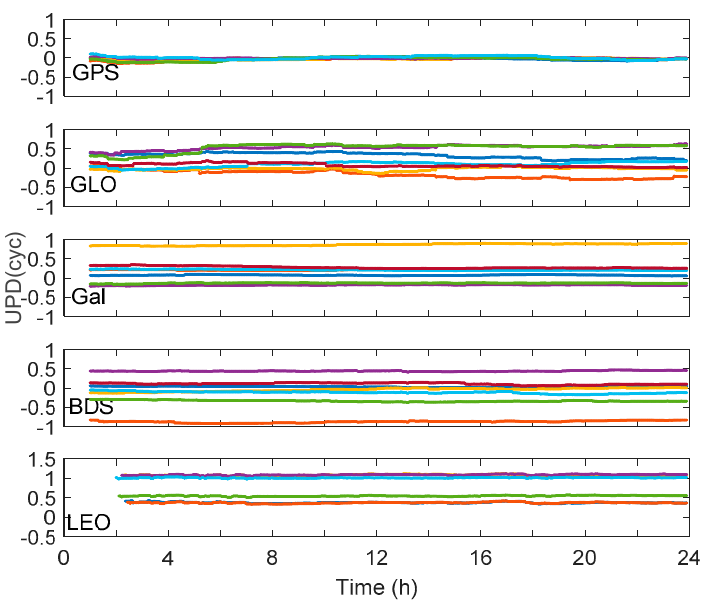
Figure 3. Narrow-lane UPD series of GPS, GLONASS, Galileo, BDS, and LEO on DOY 001, 2017. The abbreviations GLO and Gal indicate the GLONASS and Galileo, respectively. Remote Sens. 2018 , 10 , x FOR PEER REVIEW